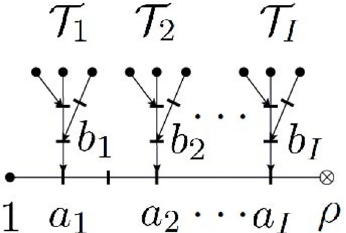
Figure 12 . The structure of a graph in the decomposition formula